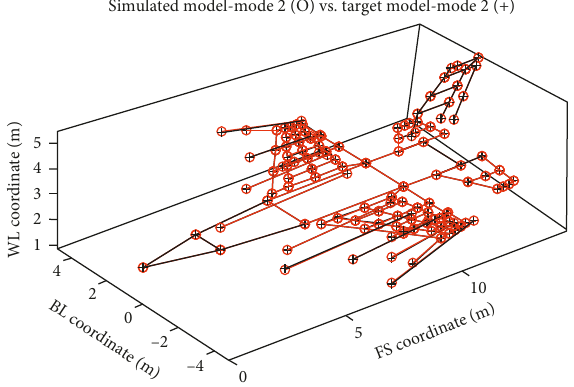
Figure 20: Mode shape for configuration 4 mode-2. Table 13: Natural frequencies for configuration 1 vs. configuration 5.